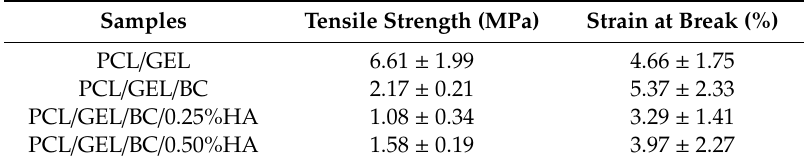
Table 3. Tensile Testing Results for PCL / GEL, PCL / GEL / BC, PCL / GEL / BC / 0.25%HA, and PCL / GEL / BC /